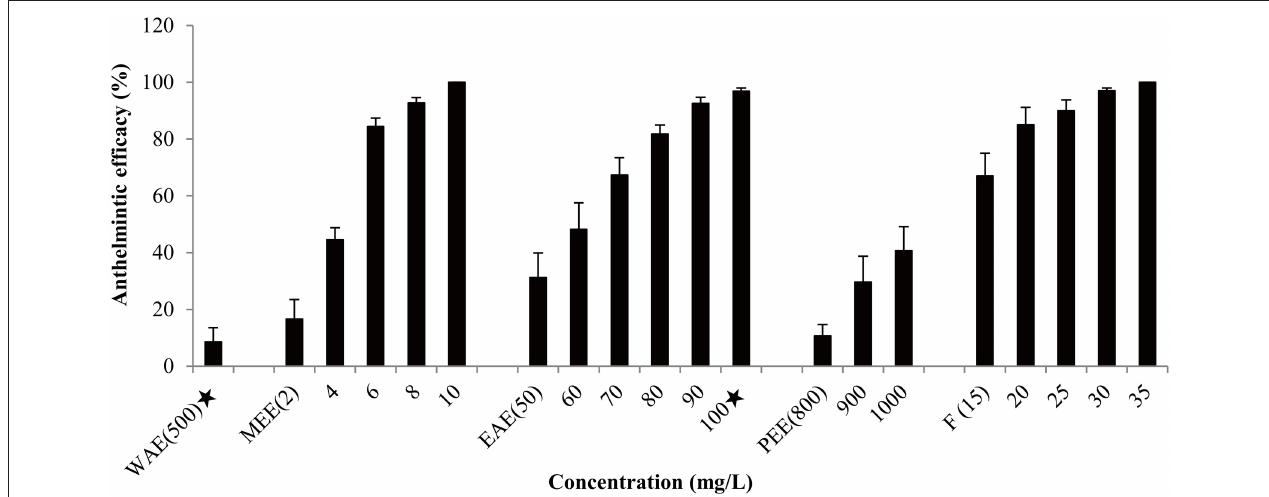
FIGURE 1 | Antiparasitic efficacy of different extracts of Dioscorea collettii var. hypoglauca and formaldehyde against Gyrodactylus kobayashii after a 48-h treatment. WAE, water extract; MEE, methanol extract; EAE, ethyl acetate extract; PEE, petroleum ether extract; F, formaldehyde. A star indicates that fish death occurred.